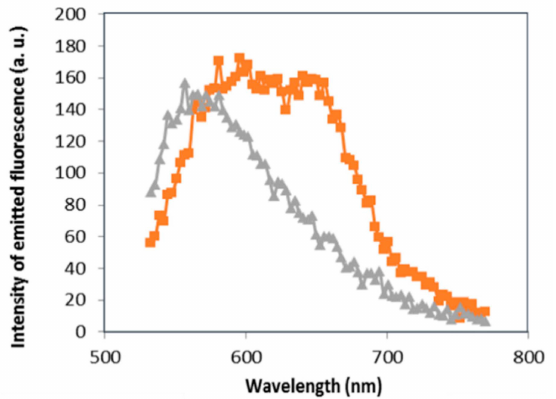
Figure 3. Effect of gold nanoparticles on the fluorescence spectra of NB bound to cationic surfactants complexes (grey and orange curves are recorded respectively from precipitations of aggregated cationic surfactants complexes without and with GNPs). Emission obtained from 514 nm excitation (lambda scan mode from a confocal microscope) and detected in the (530–775) nm